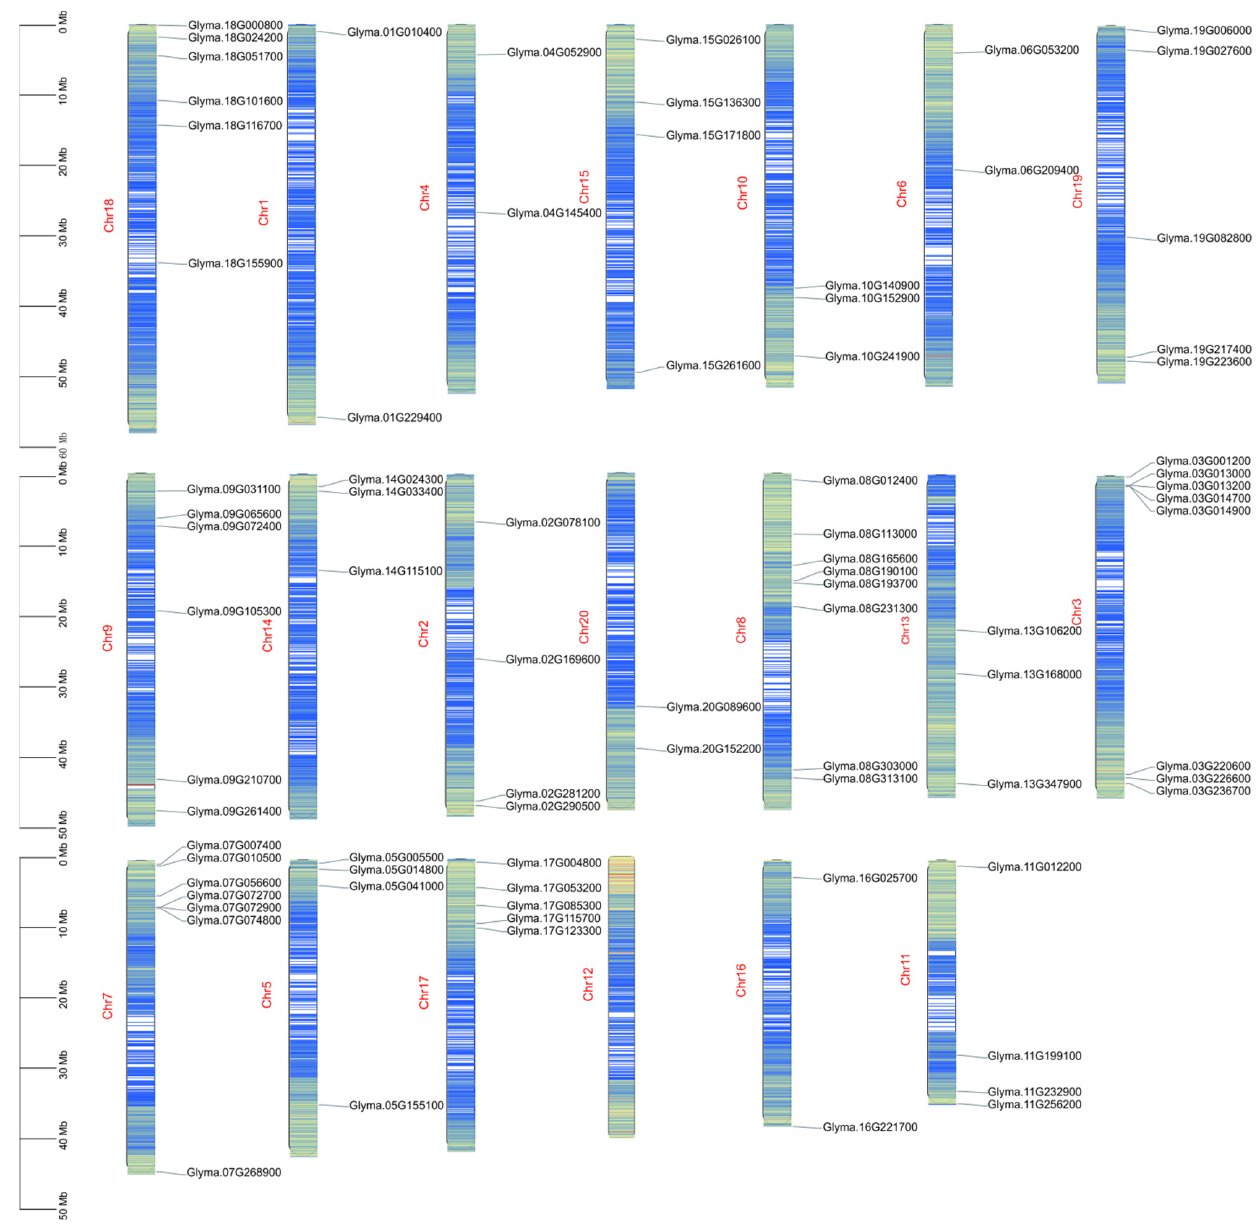
Figure 1. The chromosome distribution of the DDX genes.